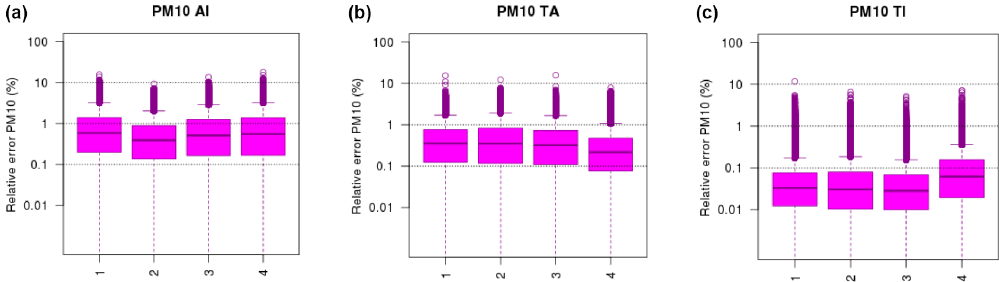
Figure 9. Relative error (%) of the PM 10 bivariate surrogate models ( a–c : AI: AGR and IND, TA: TRA and AGR, TI: TRA and IND). For each panel, the box plots of the distribution of errors are given for four models with interactions trained on different scenarios where indices in the x axis match the row of Tables 3 and 2. The distributions of relative errors include each grid point in western Europe and each day over three air pollution events (March 2015, December 2016, January 2017). The horizontal dotted lines are for 0.1%, 1% and 10% errors.